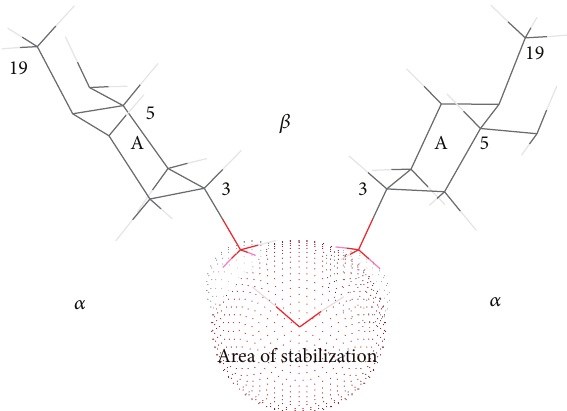
Figure 5: Area of stabilization of mixed micelle (a ring of 3 𝛼 ,12 𝛼 - dihydroxy-7-oxo-5 𝛽 -cholanoic